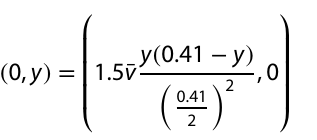
Fig. 6 Error of the drag (top) and the lift (bottom) for the viscoelas- tic FSI1